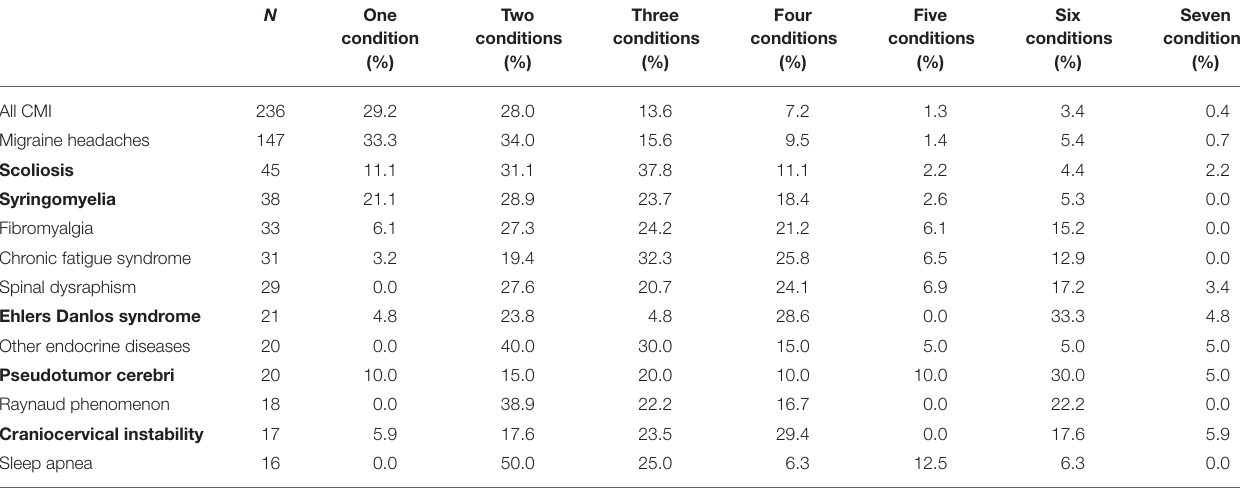
TABLE 3 | Percentage of CMI sample with more than one condition.